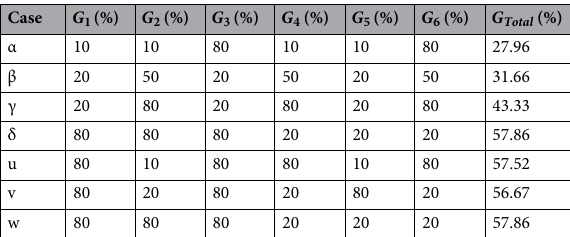
Table 5. Relative densities of MGS in Group 3 and Group